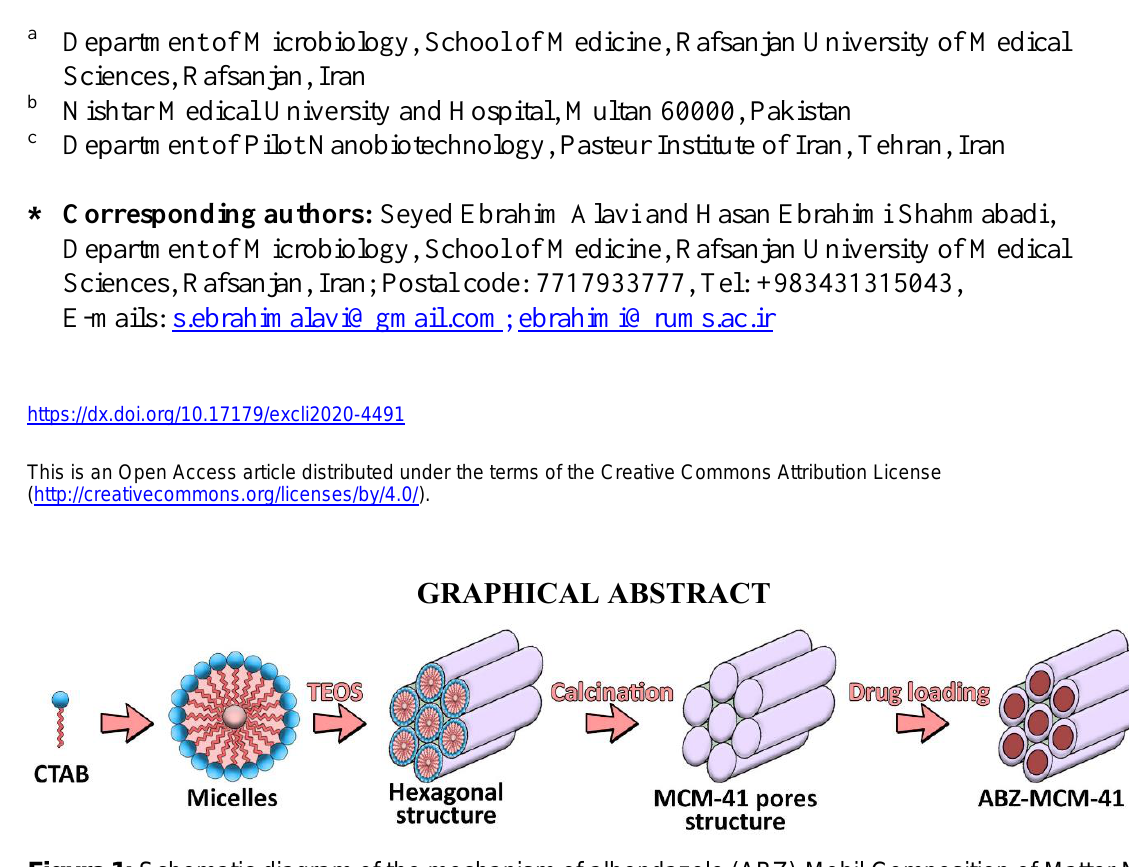
Figure 1: Schematic diagram of the mechanism of albendazole (ABZ)-Mobil Composition of Matter No. 41 (MCM-41) NP synthesis. N-cetyltrimethylammonium bromide (CTAB) is a cationic surfactant micelle and functions as a template for directing the polymerization of silica component (tetraethylorthosilicate; TEOS). The resulting mixture (CTAB+TEOS) is then crystallized under the hydrothermal condition, and the solid product (hexagonal structure) is generated. The solid product is then calcinated to remove CTAB, resulting in the final product (MCM-41 pores structure). The product is then loaded with ABZ, and ABZ-MCM-41 NPs are